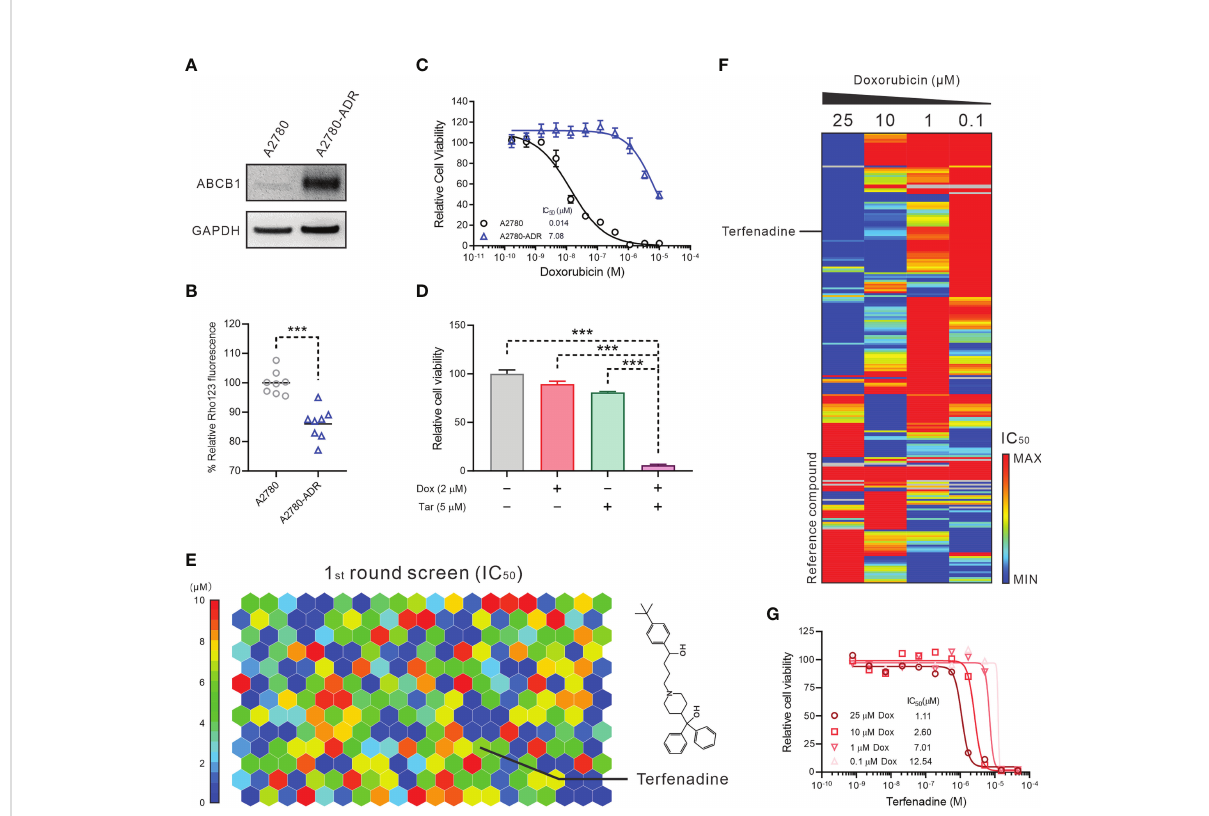
FIGURE 1 Terfenadine restores the activity of doxorubicin in MDR ovarian cancer cells. (A) Western blot analysis of ABCB1 in multidrug resistance (MDR) ovarian cancer cells A2780-ADR and its parental cell A2780. A representative image was shown here. (B) Rho123 accumulation in A2780-ADR and its parental cell A2780. (C) Dose-response curves of doxorubicin in MDR ovarian cancer cells A2780-ADR and its parental cell A2780. (D) Cell viability of MDR ovarian cancer cells A2780-ADR treated with 2 m M doxorubicin (Dox), 5 m M tariquidar (Tar), or both for 48 hours. DMSO was used as a non-treated control. (E) The heatmap shows 246 compounds were identi fi ed that ef fi ciently inhibited the proliferation of A2780- ADR cells as monotherapy in the fi rst round of screening. The color represents the IC 50 of each compound, as the scale bar showed. (F) The heatmap shows enrichment of A2780-ADR for a strong response to speci fi c drug categories (columns) combined with doxorubicin (rows). Drug-category-response scores are based on IC 50 ( m M). (G) A2780-ADR dose-response curves to terfenadine in the presence of 0.1, 1, 10,